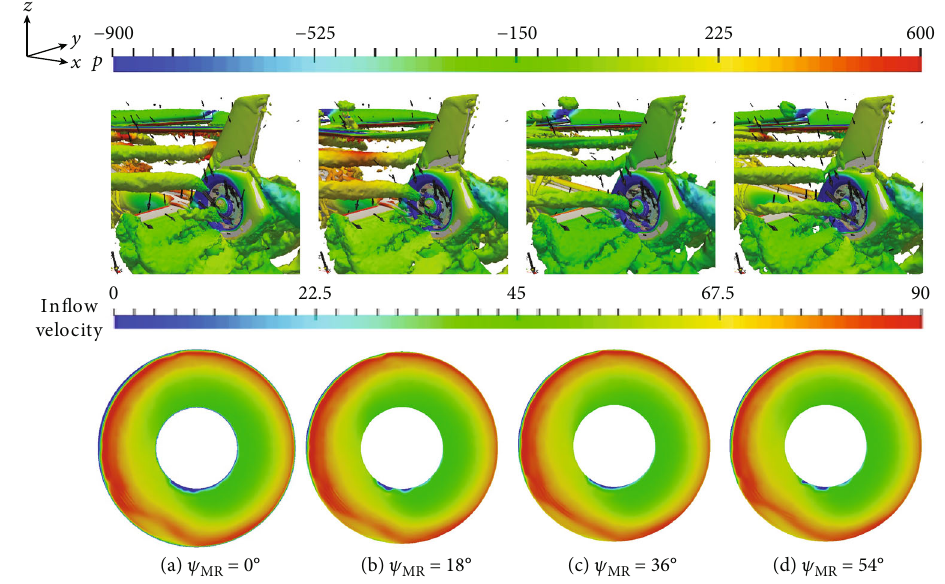
Figure 8: Q -criteria contour for pressure (upper) and tail rotor disk in fl ow velocity (lower).